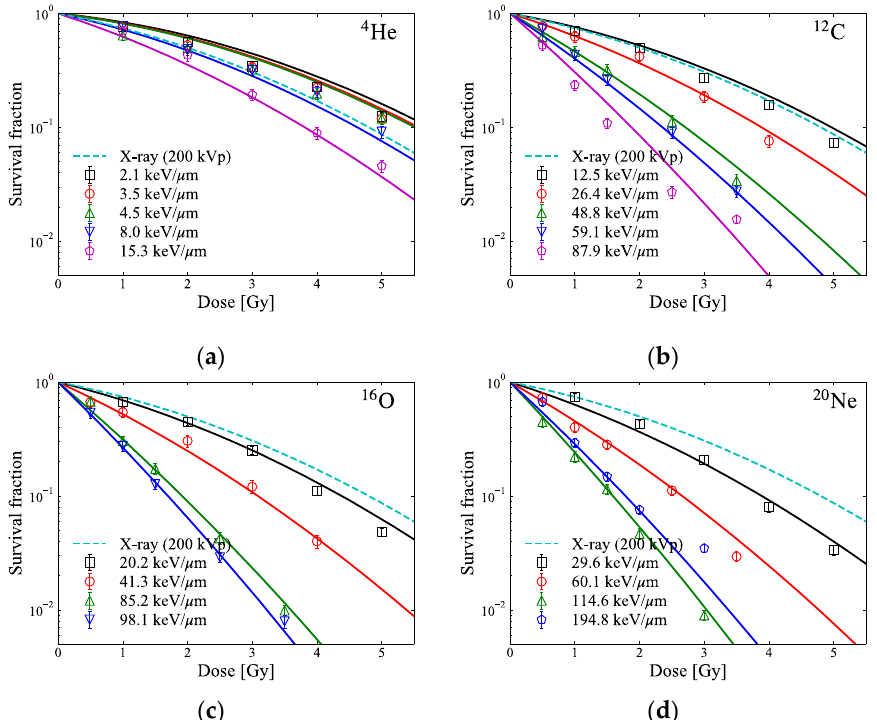
Figure 2. In vitro survival fraction (markers) for HSGc-C5 cells for different LETs of pristine ( a ) 4 He-, ( b ) 12 C-, ( c ) 16 O-, and ( d ) 20 Ne-ion beams (reported in [15]) and the survival curves (solid lines) pre- dicted by the measured dose and y * with the MK model parameters: α 0 = 0.07 Gy − 1 , β = 0.0474 Gy − 2 , R n = 6.6 μ m, r d = 0.43 μ m, and y 0 = 255 keV/ μ m. The survival curves of HSGc-C5 cells from the 200 kVp X-ray exposure (reported by [15]) calculated by the LQ model ( α X = 0.252 Gy − 1 , β X = 0.0474 Gy − 2 ) are indicated by broken lines, respectively. The smallest values of the variance for 4 He-, 12 C-, 16 O-, and 20 Ne-ion beams calculated using Equation (7) are 0.16, 0.18, 0.05, and 0.16, respectively.